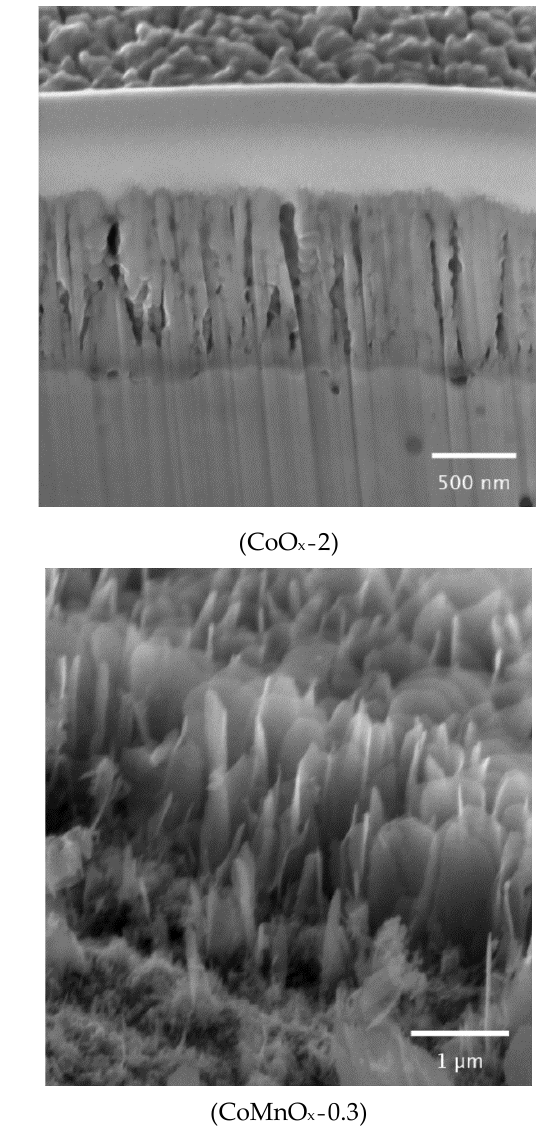
1 Figure 3. Profiles of the oxide layers deposited on stainless steel